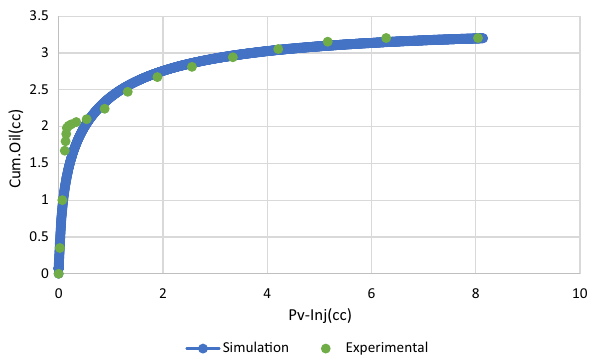
Fig. 12 History matching of cumulative oil production in water flood- ing